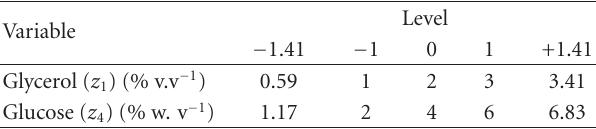
Table 5: Coded and actual levels of the two variables in the experimental design.